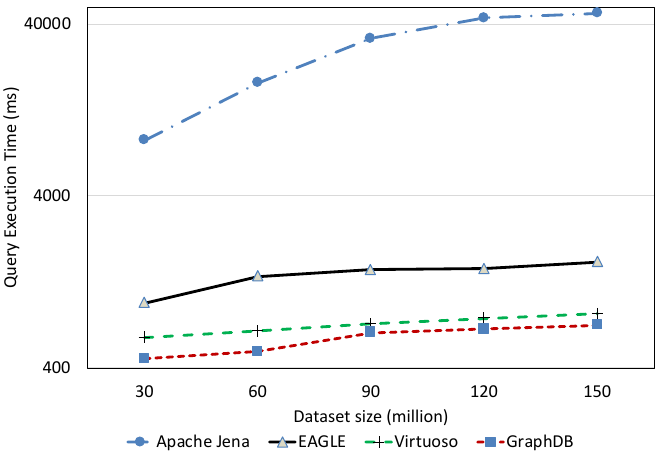
Figure 20. Q1 execution time with respect to spatial dataset size (in